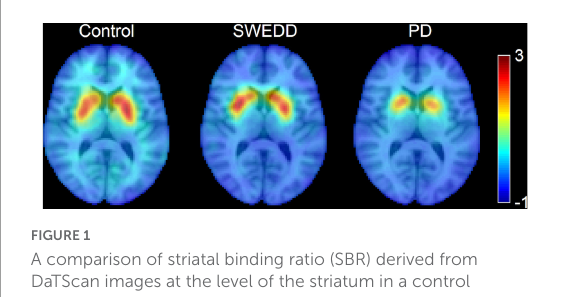
FIGURE1 A comparison of striatal binding ratio (SBR) derived from DaTScan images at the level of the striatum in a control participant (left) , scans without evidence of dopaminergic deficit (SWEDD) participant (middle) , and PD participant (right)